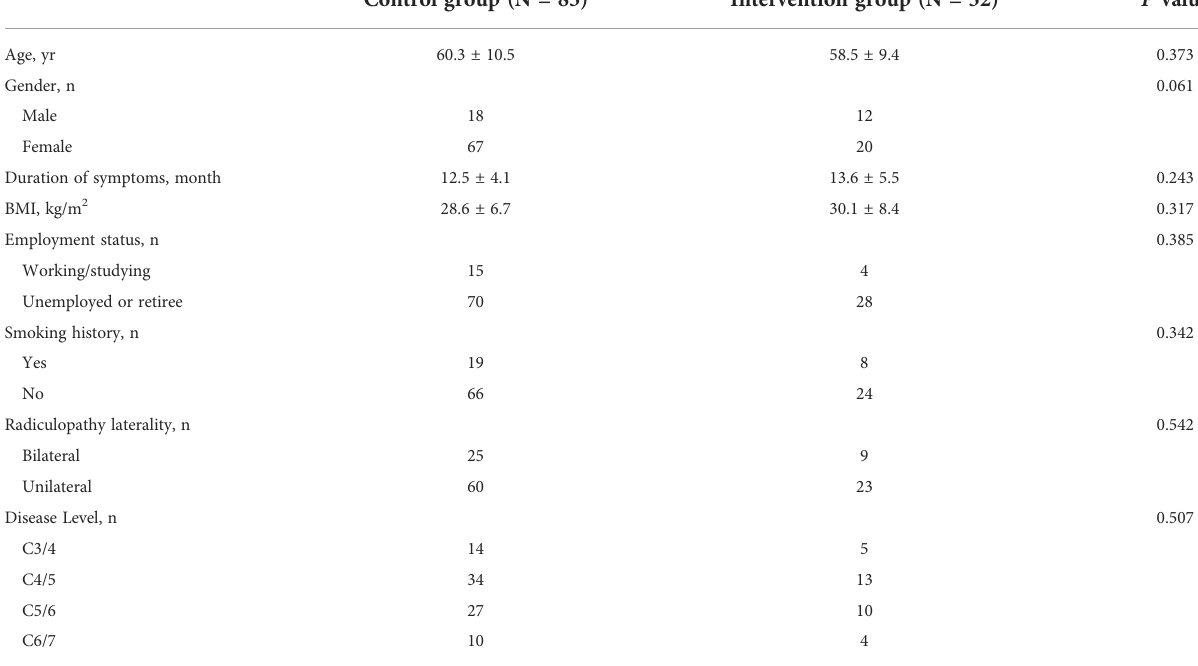
TABLE 1 Comparison of clinical basic characteristics between the two